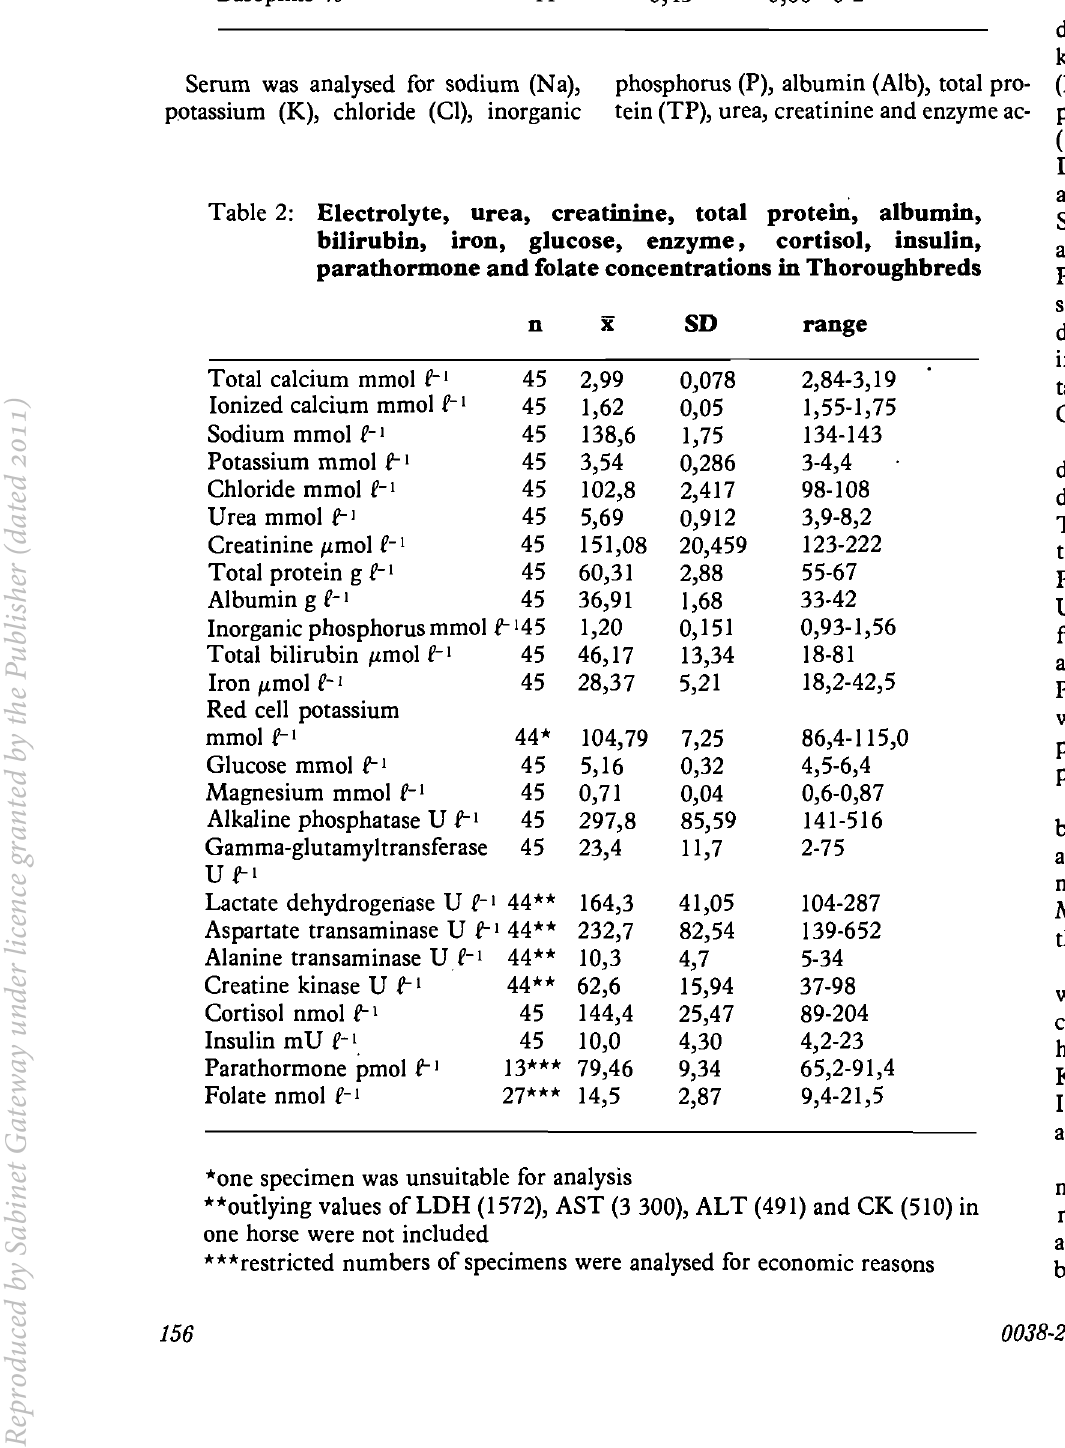
Haemoglobin gi- I